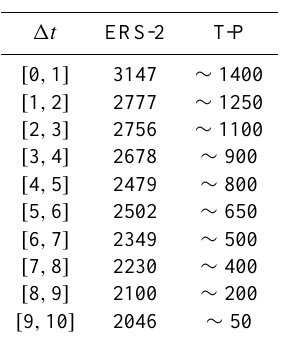
Table 1. Number of crossover points when considering one cy- cle of ERS-2 and Topex-Poseidon (T-P) and a time sampling, 1t ≤ 10days. This time interval has been sub-divided into sub- intervals with a one day width.